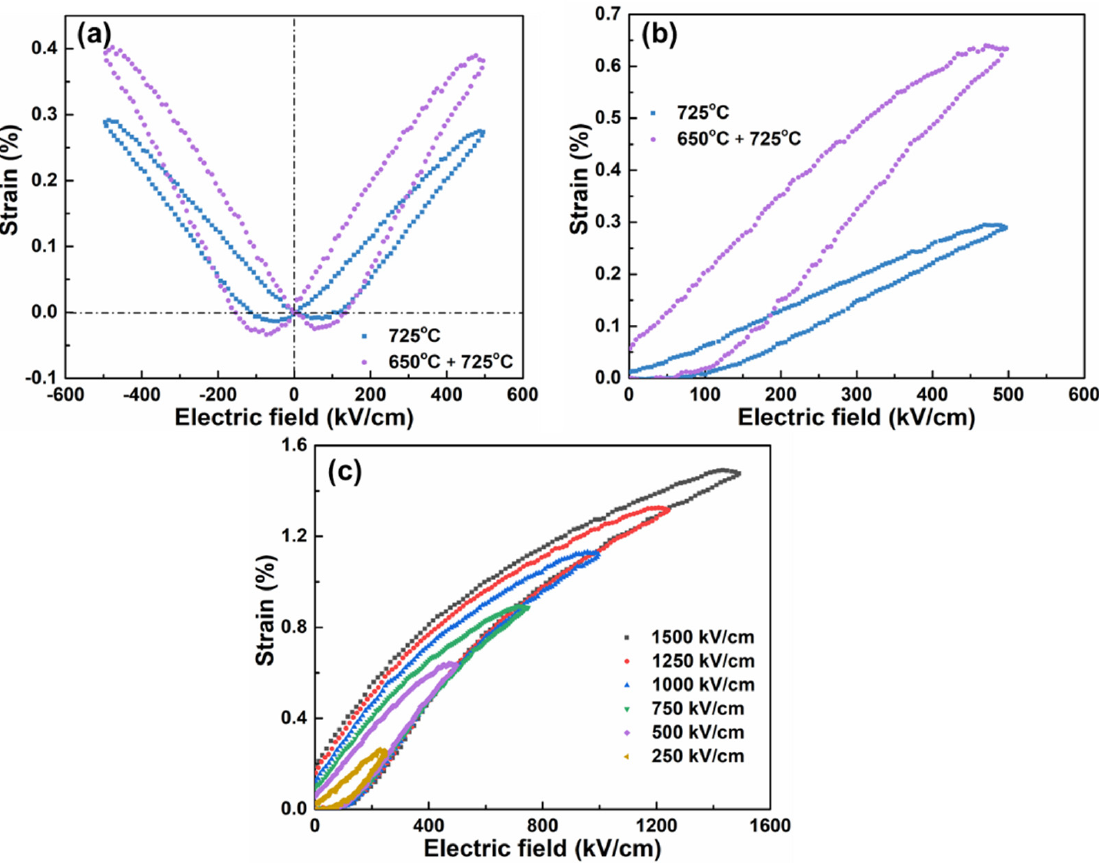
Figure 6. ( a ) Bipolar and ( b ) unipolar strain hysteresis ( S – E ) loops at 0.5 MV/cm for the BNT–5.5BZ thin films annealed under different conditions; ( c ) unipolar S – E loops as a function of the electric field for the “650 °C + 725 °C” thin films.